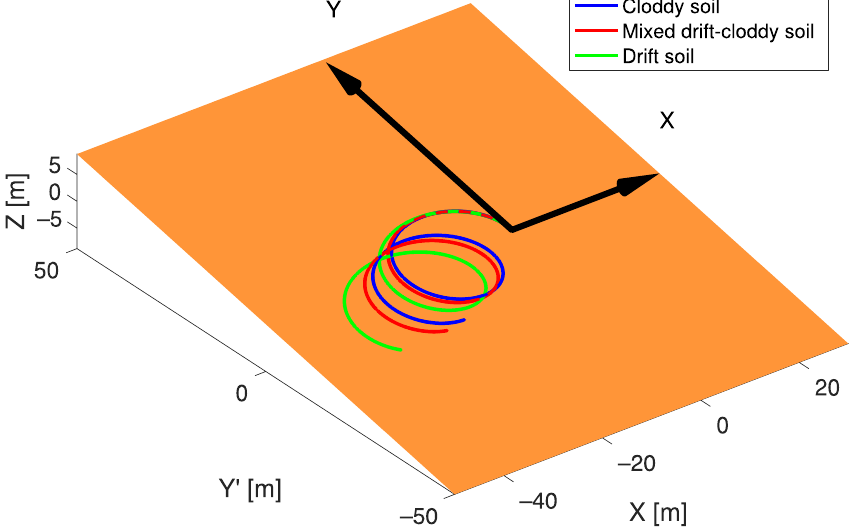
Figure 4. Rover’s trajectories in the 3D space on a 10 ◦ slope with constant steering angle δ = 4 ◦ and adaptive speed V .